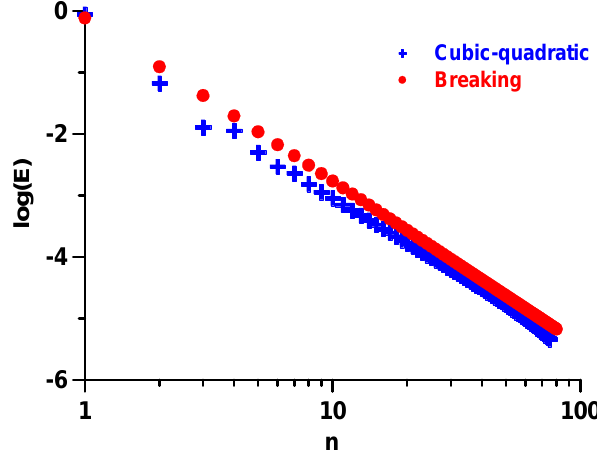
Figure 10. Spectrum of a Riemann wave with CQ = 1 at breaking time against breaking power asymptotic